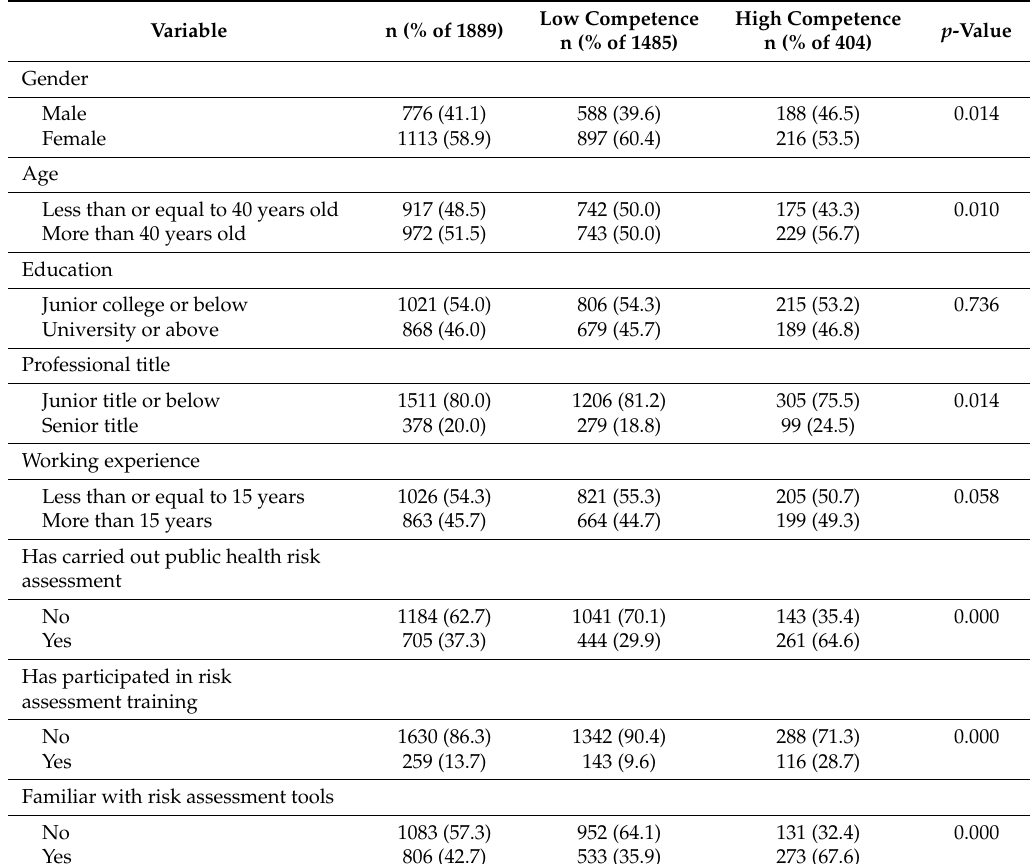
Table 1. Bivariate analysis between perceived competencies of risk assessment and characteristics of study participants.